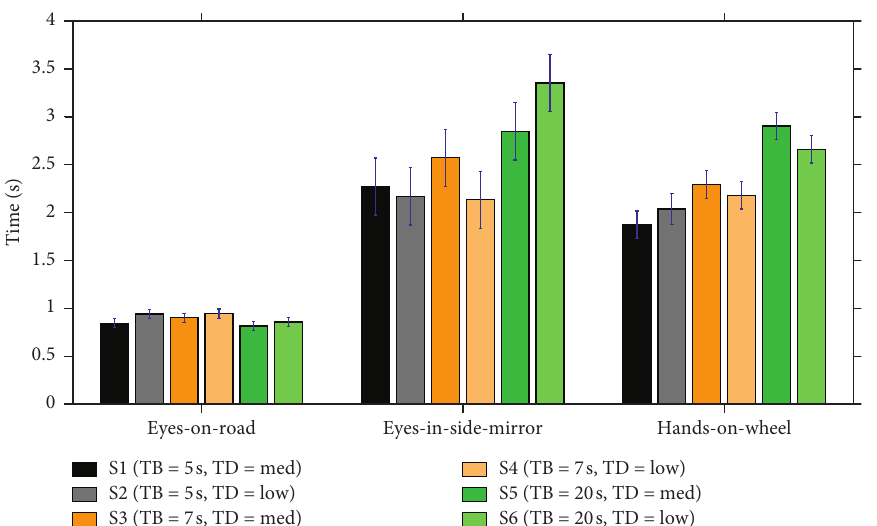
Figure 11: Means of the eyes-on-road time, eyes-in-side-mirror time, and hands-on-wheel time for the six scenarios. Error bars indicate standard